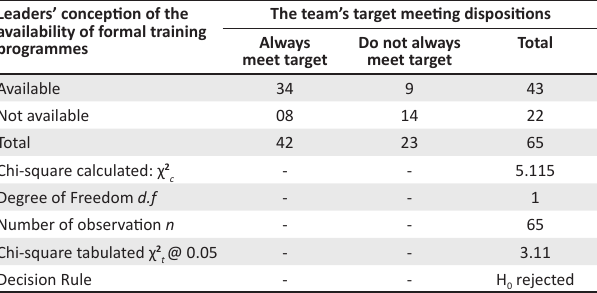
TABLE 3: Relationship between leaders’ conception of the availability of training programmes and the target meeting prospect of the team. Leaders’ conception of the availability of formal training